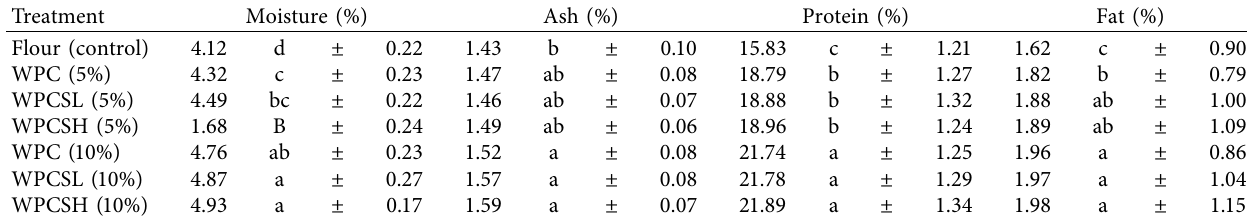
Table 3: Chemical composition after processing.